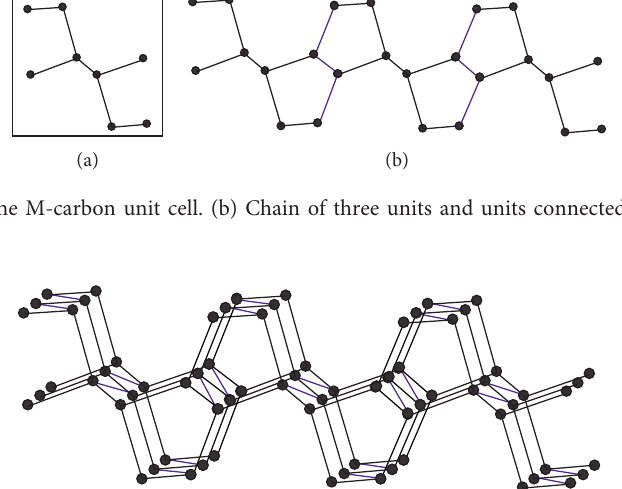
Figure 3: The odd layer (for t � 1) of three chains and bonding of chains is shown by blue edges.